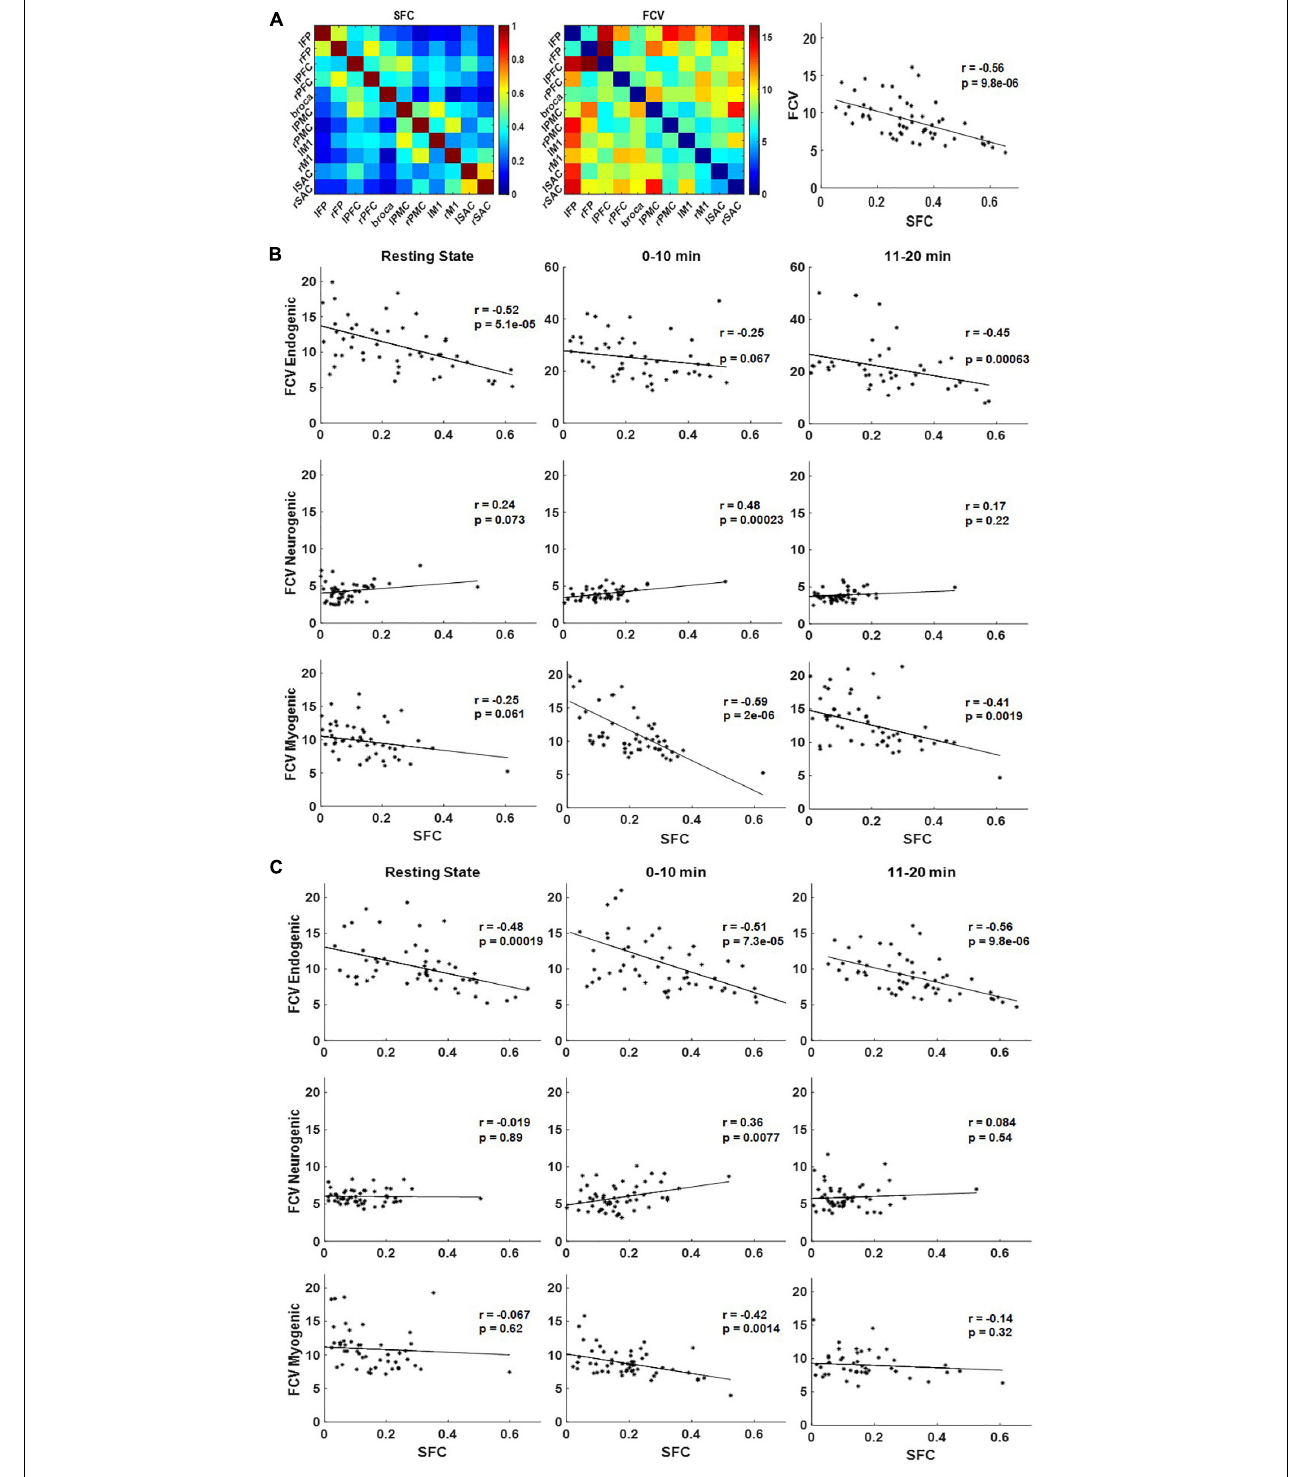
FIGURE 6 | Pattern comparison between static functional connectivity (SFC) and functional connectivity variability (FCV) at endogenic, neurogenic, and myogenic frequencies for inactive and active subjects during the handgrip task. (A) A representative example of the group-averaged SFC matrix (left), the FCV matrix (middle), and the linear relationship between them (right). (B) Correlation plots between SFC and FCV for inactive subjects and (C) active subjects at endogenic (top), neurogenic (middle), and myogenic (bottom) frequencies during resting state (left), 0–10 min (middle), and 11–20 min (right) of the handgrip task.